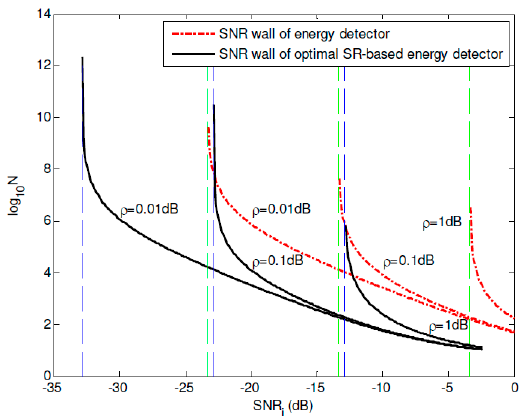
Figure 9. SNR walls comparison under SNR i = − 25 dB.